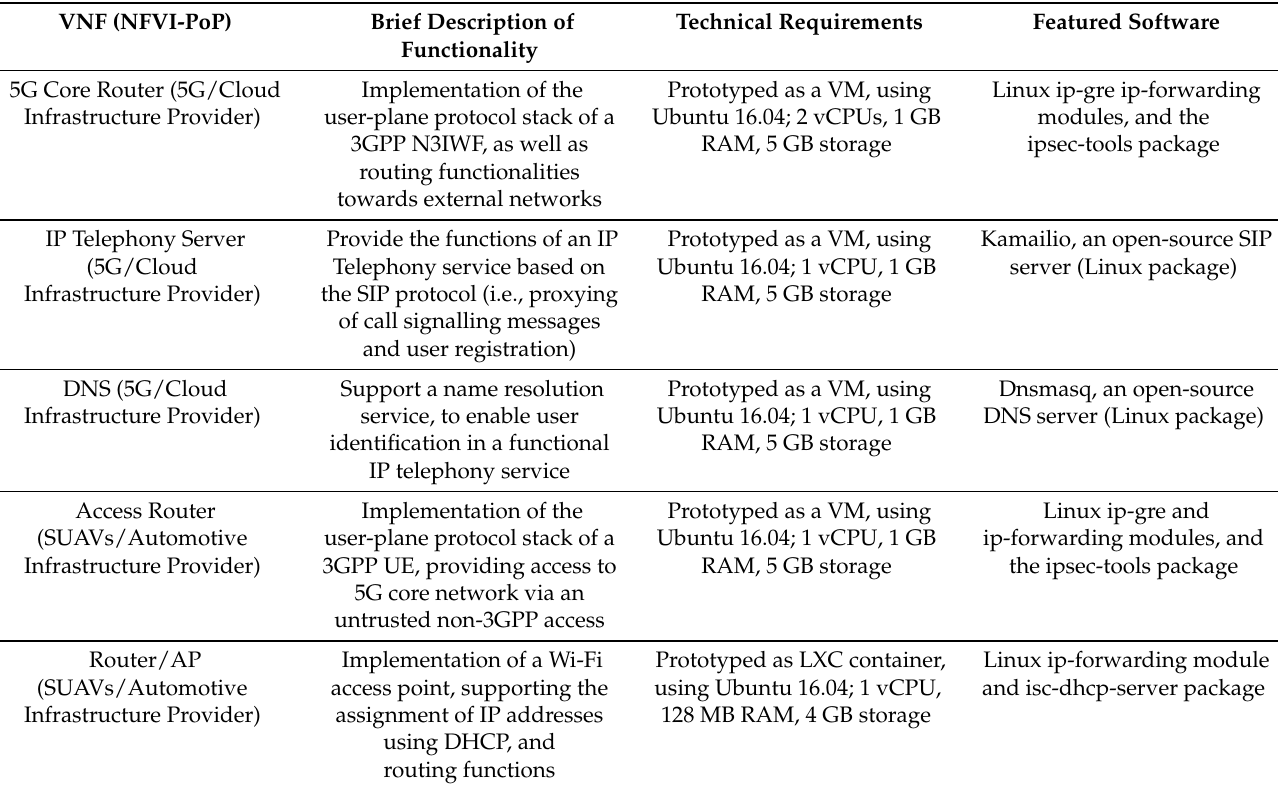
Table 1. VNFs technical implementation